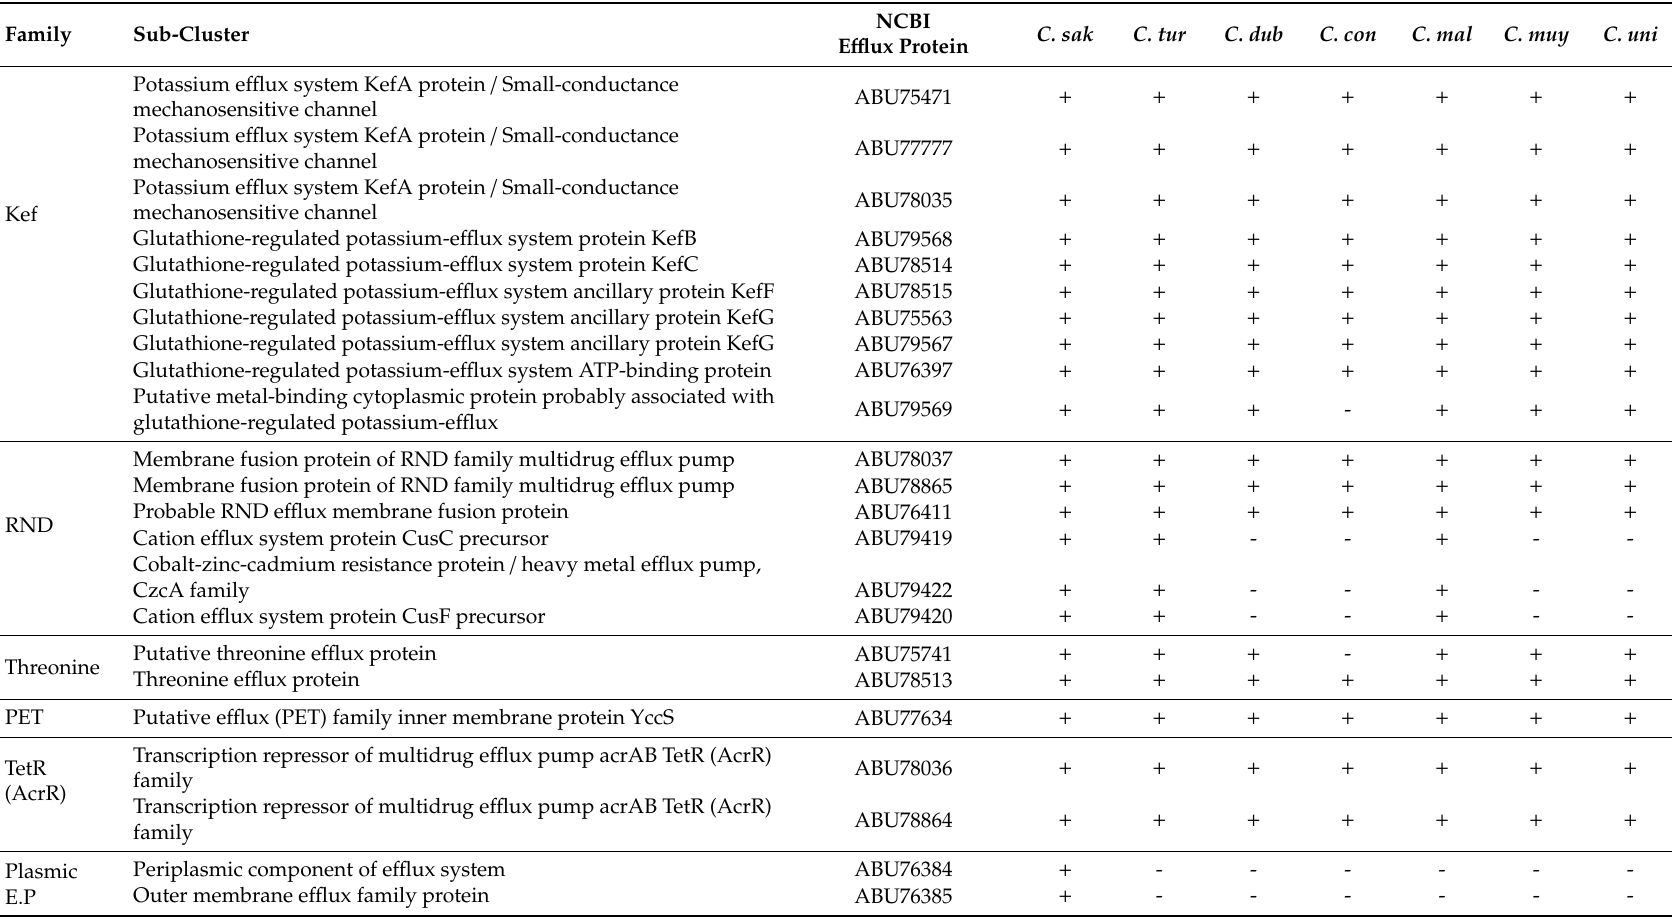
Table 2. Prevalence and distribution and NCBI protein annotations of e ffl ux pump associated genes among the seven Cronobacter species as described on the pan-genomic Cronobacter microarray a